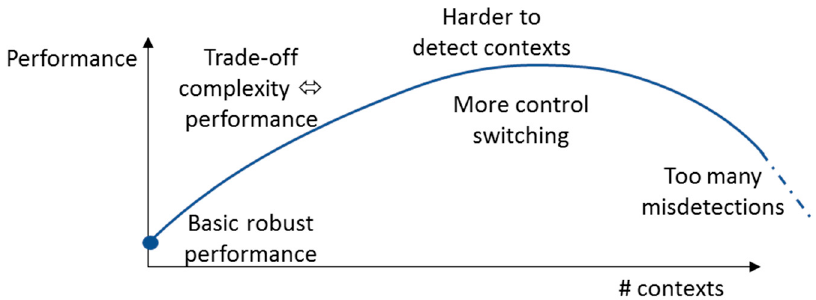
Figure 4. The performance of the context-aware controller will be optimal with the right balance between enough complexity and not too many